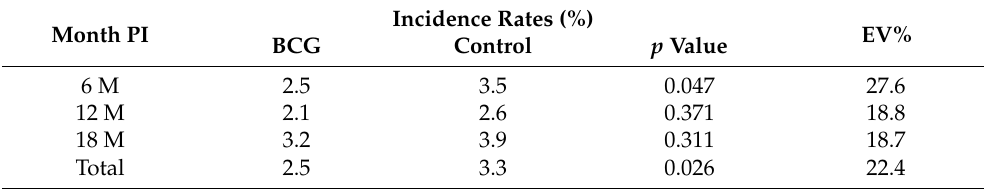
Table 2. Incidence rates and efficacy of the vaccine (EV%) at 6, 12 and 18 months post-inoculation. Month PI